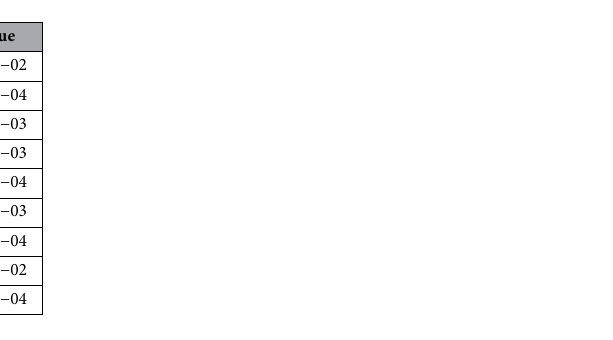
Table 8. Results of the McNemar’s test performed between the proposed ensemble model and the base learners used: null hypothesis is rejected for all cases.